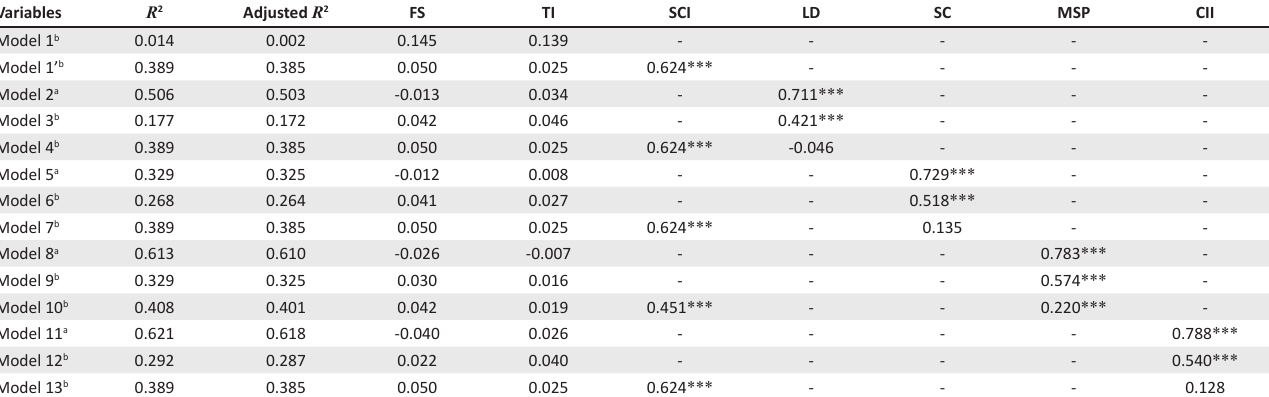
TABLE 4: Regression results for internal process performance. Variables R